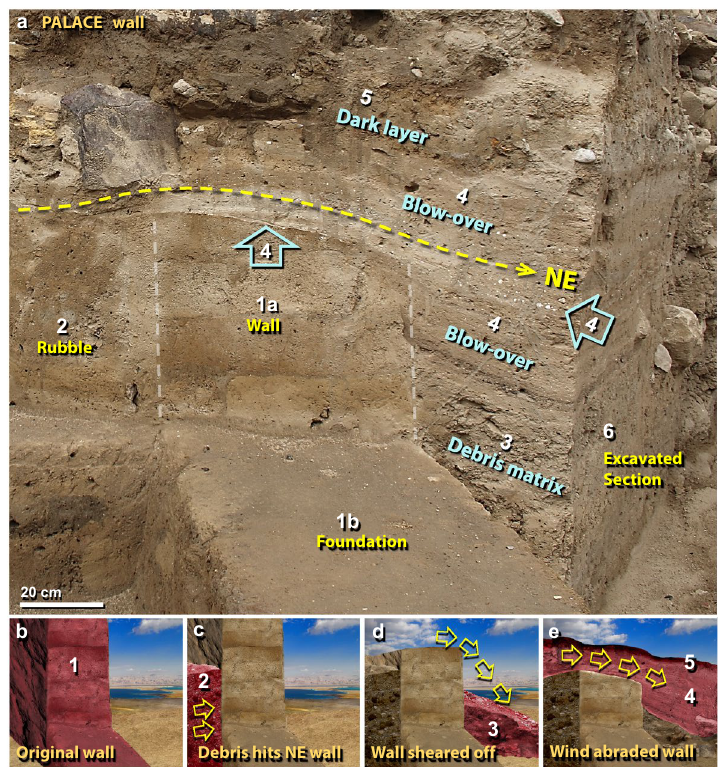
Figure 16. High-velocity effects. ( a ) Photo of an excavated section of the palace wall on upper tall. In the center are the lower courses of the mudbrick wall (#1a, between white dashed lines) and foundation (#1b). Yellow dashed line with arrow indicates wind direction of blow-over to NE. Also, note the lines of white fragments of broken plaster at two blue arrows (#4), where the curved wall top displays intense wind abrasion. At the right side of the image, #6 marks the limit of modern excavation. The sequence of wall destruction is illustrated in panels ‘ b ’ to ‘ e ’ below. ( b ) An artistic depiction, re-creating the pre-destruction mudbrick wall and foundation highlighted in red (#1). ( c ) Rubble in red (#2) was blown against the SW-facing side of the wall; material mainly consists of pulverized mudbricks and shattered potsherds. ( d ) Section of wall higher than several courses of mudbrick was demolished and blown to the NE to form the debris matrix (#3). ( e ) High-velocity winds blew from SW to NE (arrows), severely abrading the top of the wall, and burying it in debris. Winds produced the laminated ‘blow-over’ (#4), containing small pulverized mudbricks, fragments of white wall plaster, and limestone spherules stripped from interior walls. Settling on top, the ‘dark layer’ (#5) is mostly composed of charcoal and ash from the city-wide fires, along with post-destruction fine